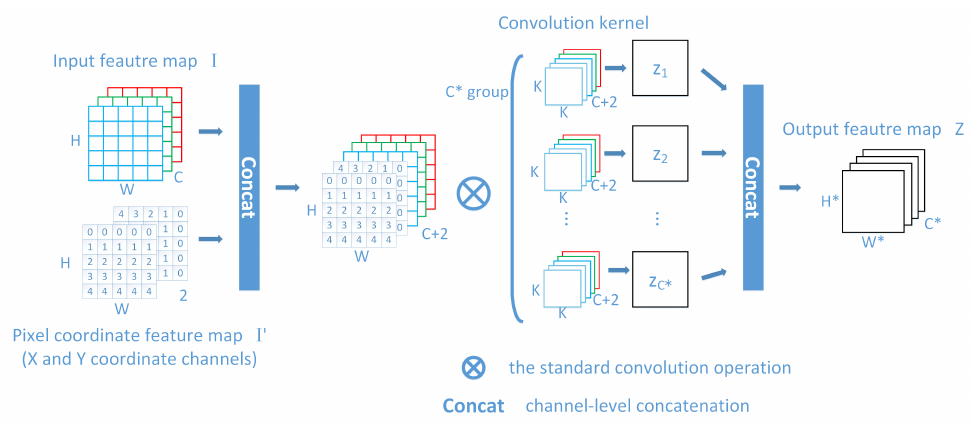
Figure 2. The architecture of the coordinate